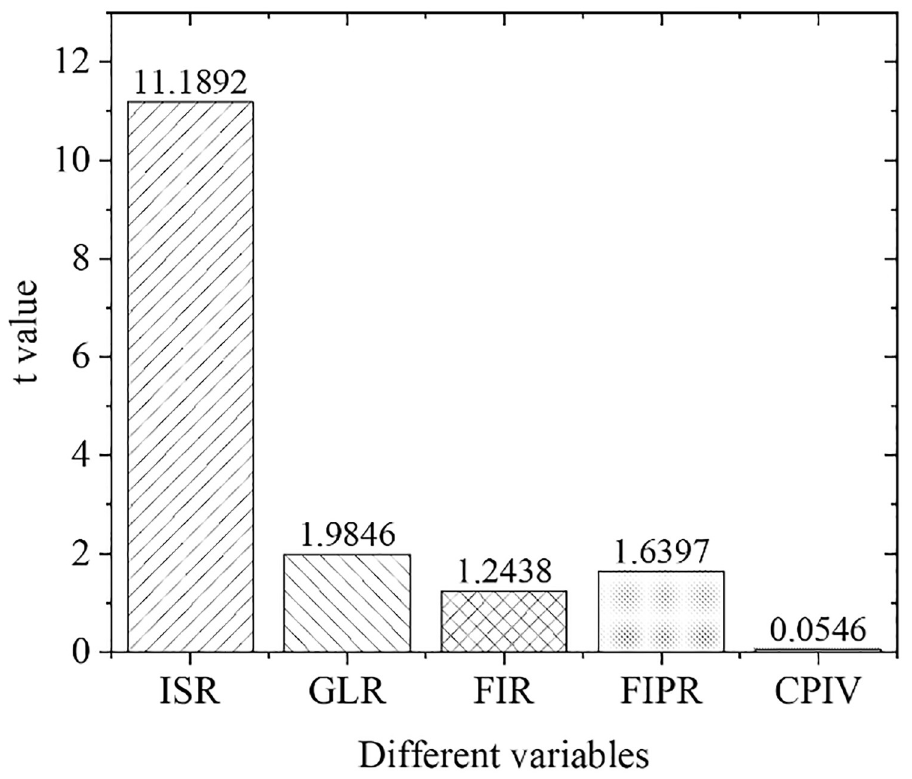
Fig 12. Calculation results of t value in Western